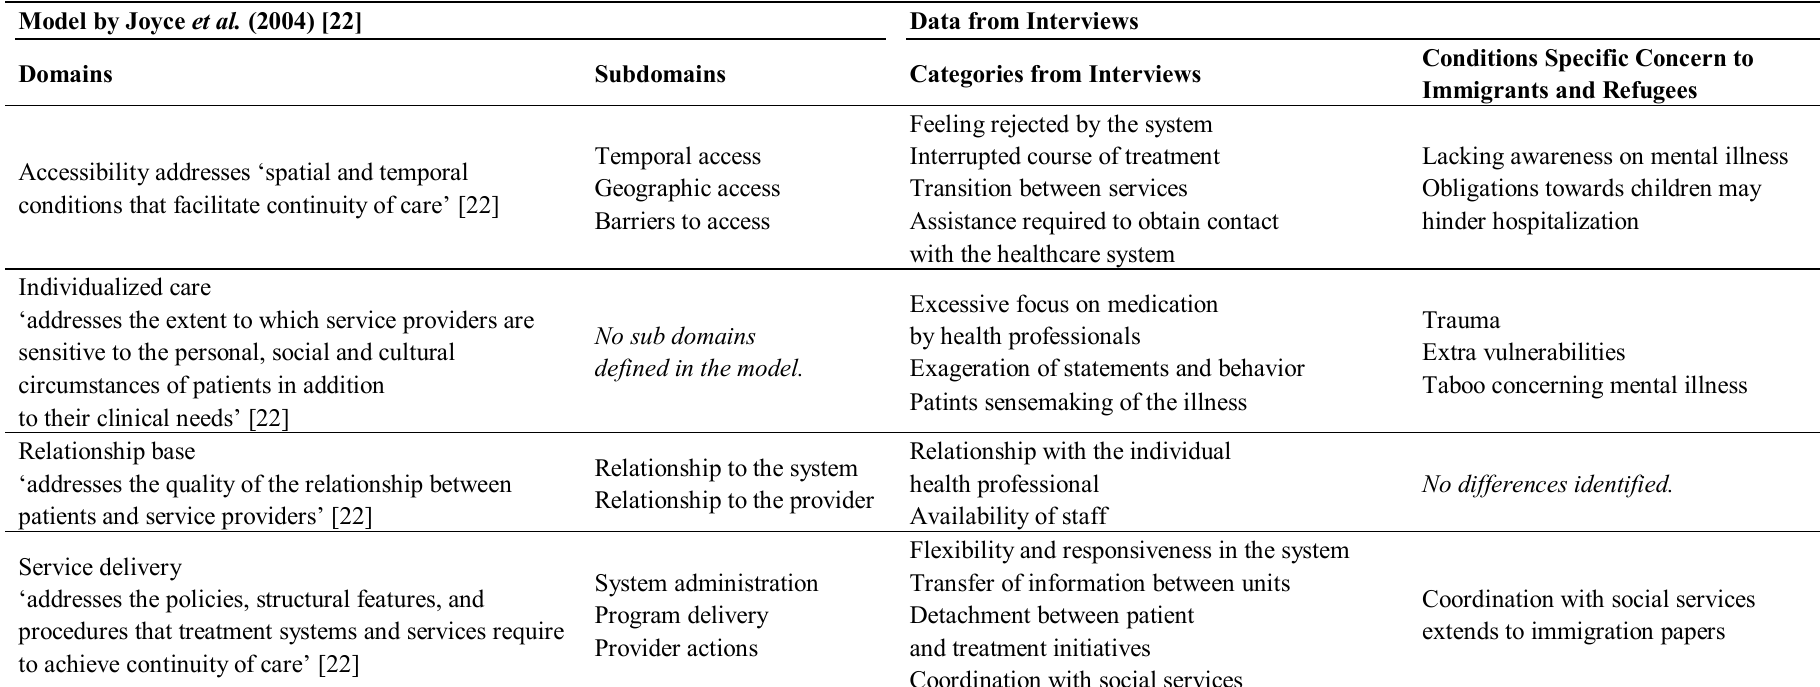
Table 2. Main findings compared to the model of continuity of care by Joyce et al.